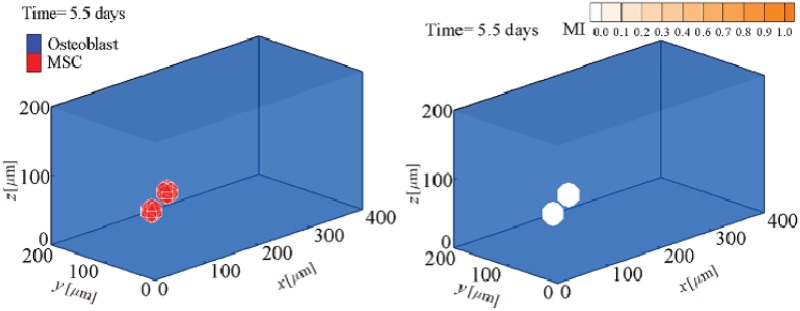
MSC proliferation and differentiation within a substrate of 45 kPa stiffness after 5.5 days.MSC proliferation (see also S1 Video).